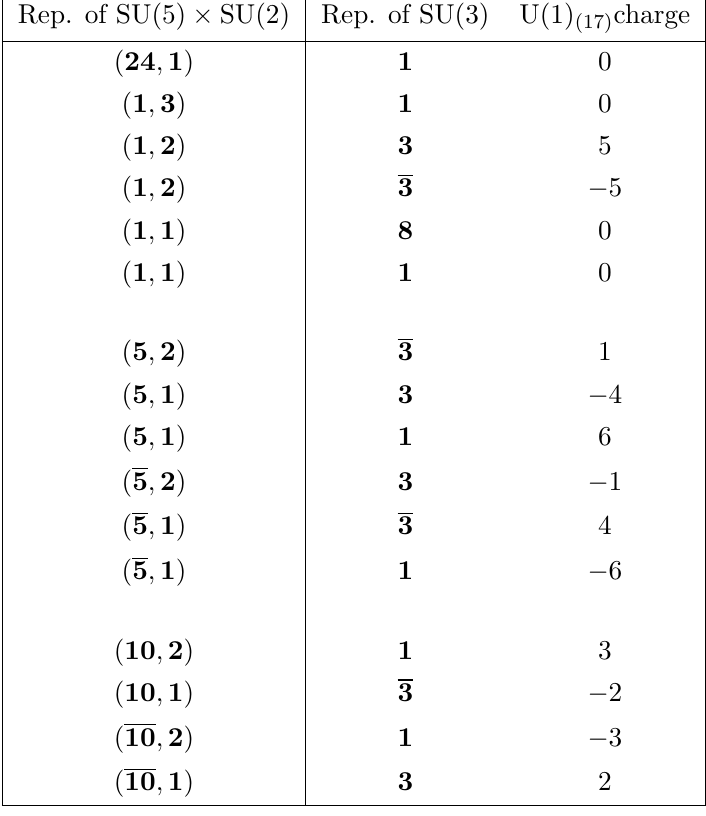
Table 5 . Decomposition of 248